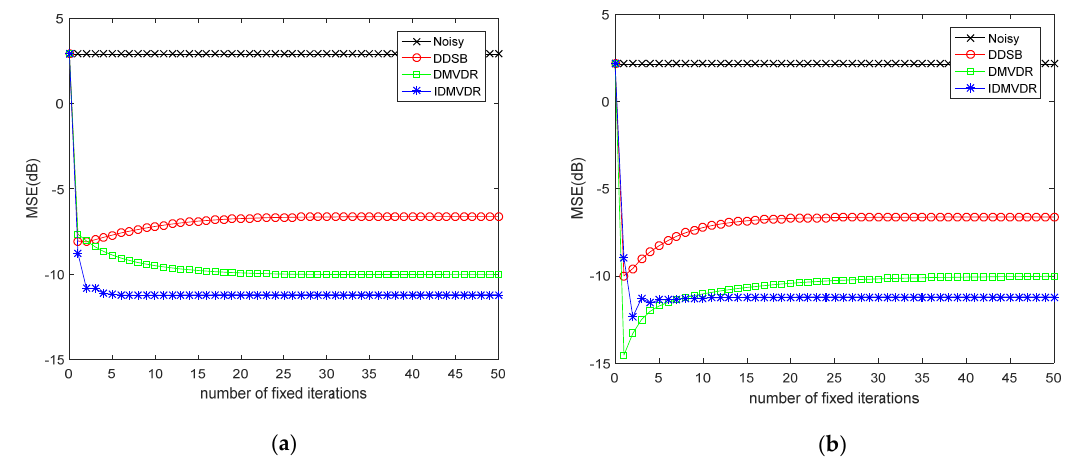
Figure 6. The MSE variations in the WASN with N d = 10: ( a ) MSE of node 1 in each iteration; ( b ) MSE of node 5 in each iteration.